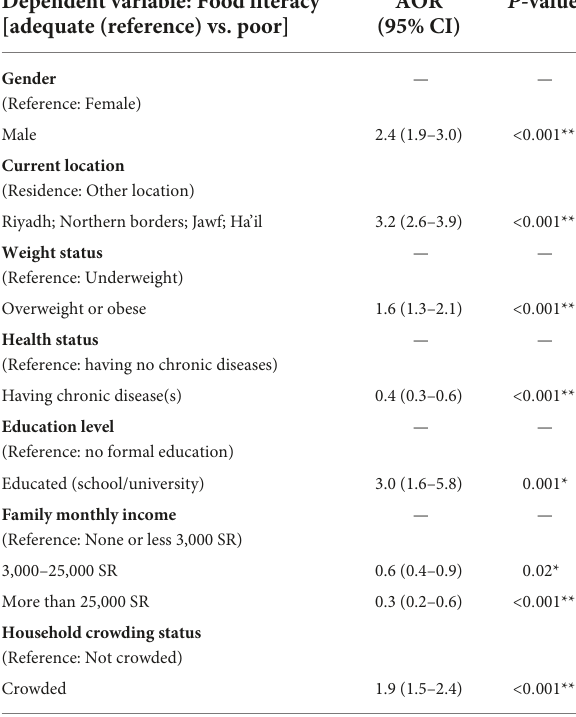
TABLE 4 The determinants of parental food literacy: Binary logistic regression analysis. Dependent variable: Food literacy [adequate (reference) vs.